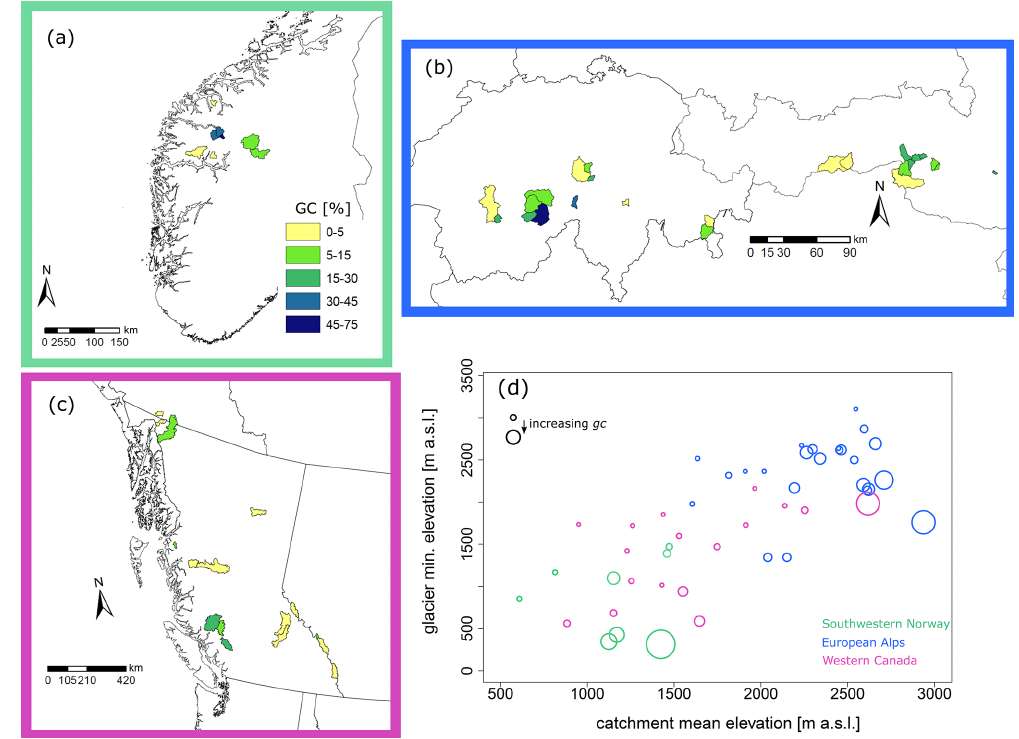
Figure 1. Location of the glacierized catchments in (a) southwestern Norway, (b) the European Alps, and (c) western Canada and catchment elevation characteristics (d) . Size of the circles in (d) scale with relative glacier cover, ranging between 0.02%–71.7%.